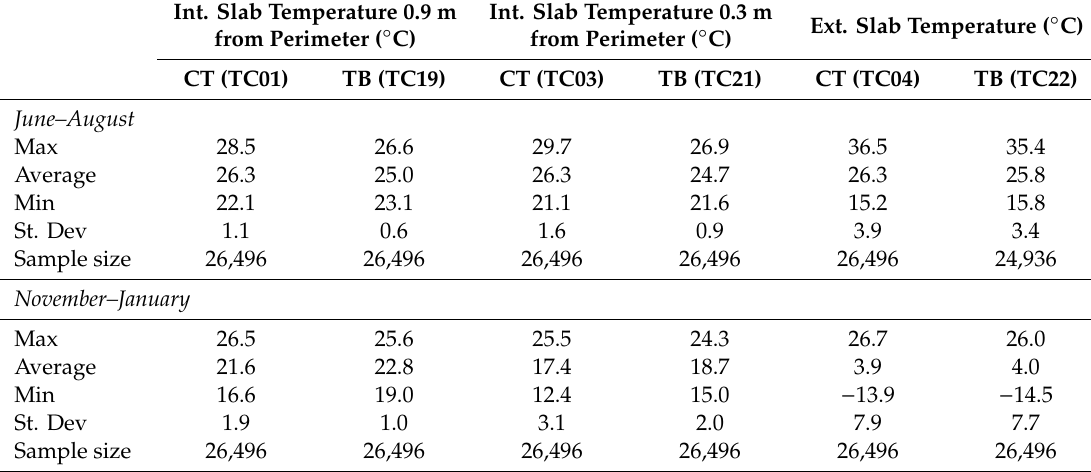
Table 2. Slab temperature of the control and thermally-broken balconies (pair #1).